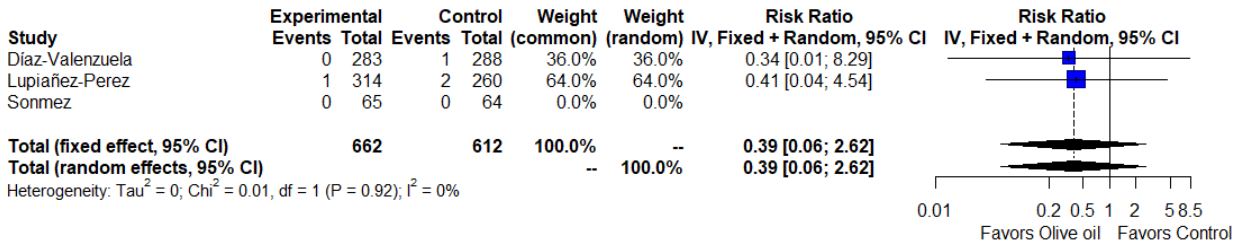
Figure 4. Safety analysis (forest plot). The blue squares represent the point estimate of the effect size and sample size. The lines on either side of the box represent a 95% confidence interval (CI). The rhombus represents pooled results [17–19].